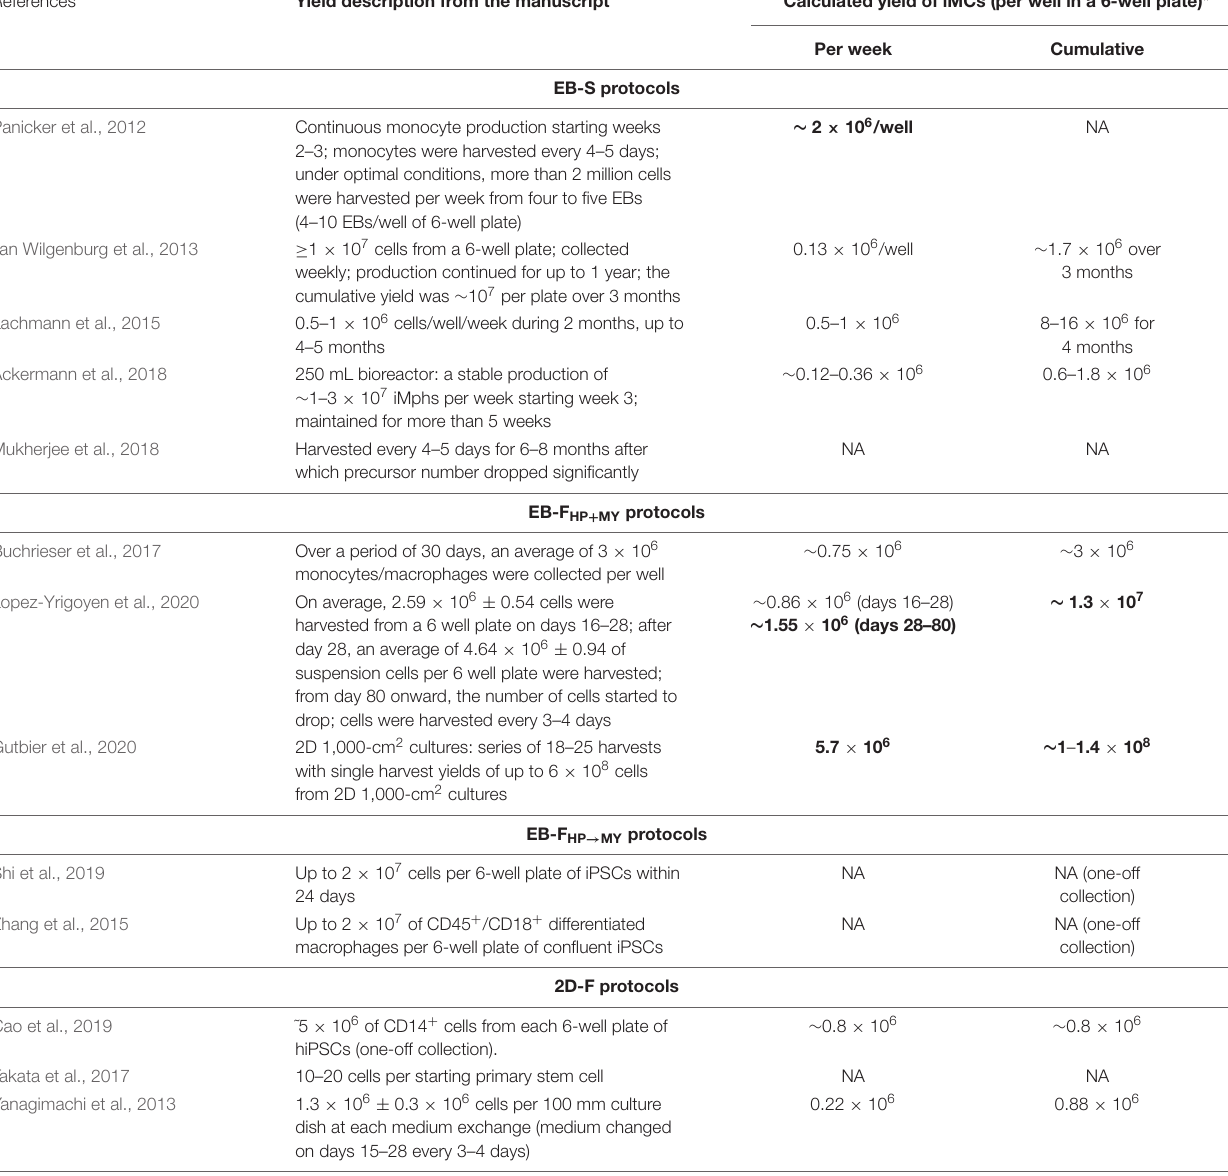
TABLE 9 | The yield of iMCs/iMphs obtained in different types of